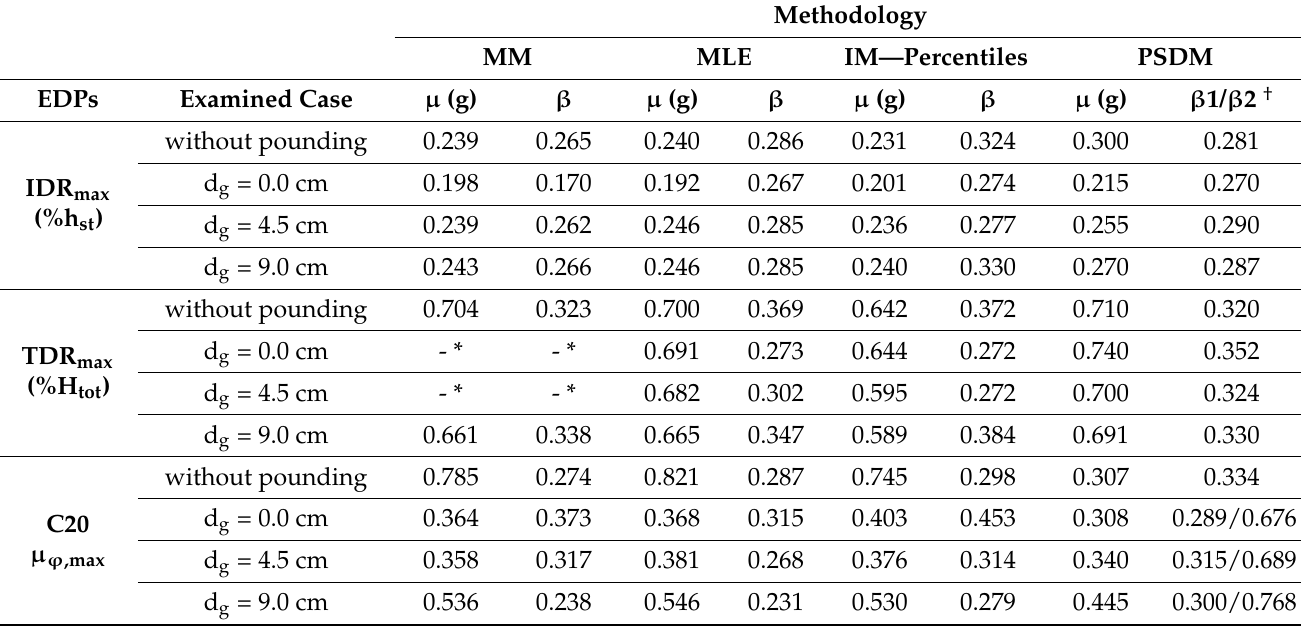
Table 2. Median µ and logarithm standard deviation (dispersion) β